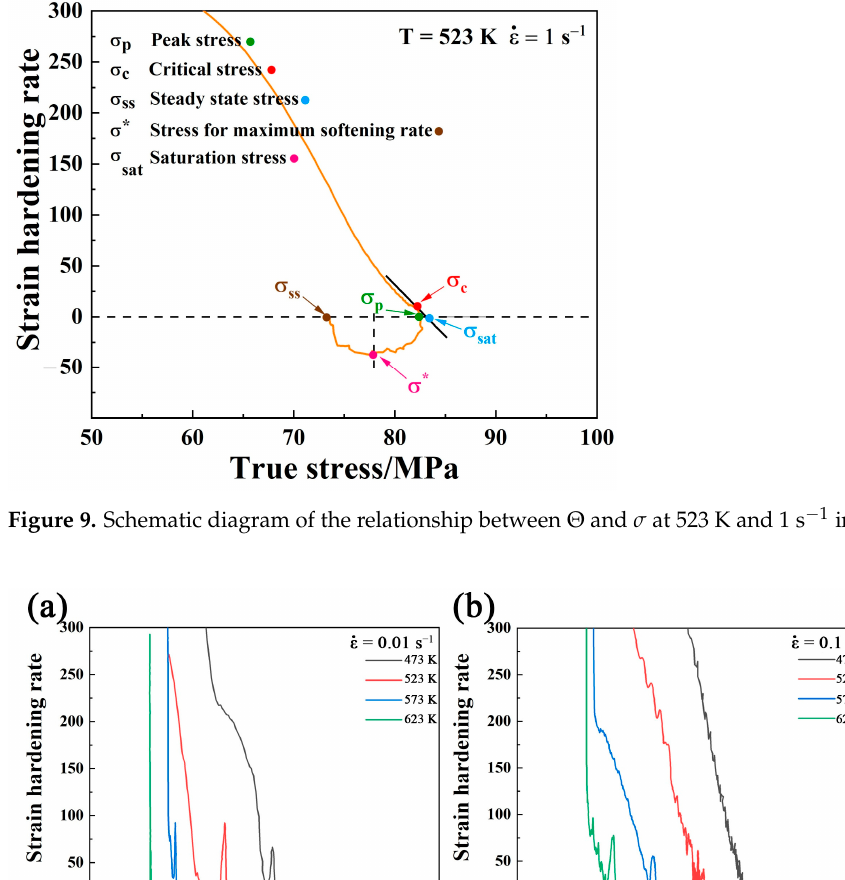
Figure 9. Schematic diagram of the relationship between Θ and σ at 523 K and 1 s − 1 in Mg-3Bi al- loy.